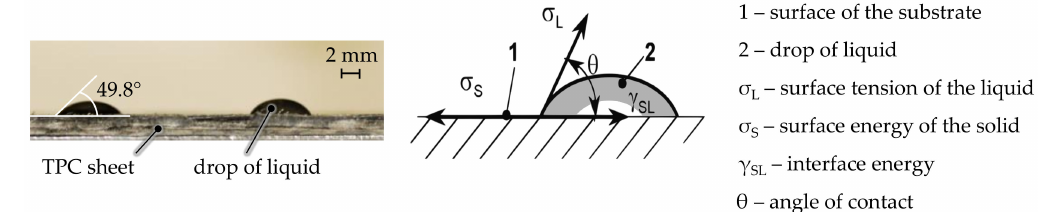
Figure 2. Applied drop for contact angle measurement ( left ) and analyzed properties ( right ) [24] (copyright accessed from Berlin Beuth Verlag GmbH).